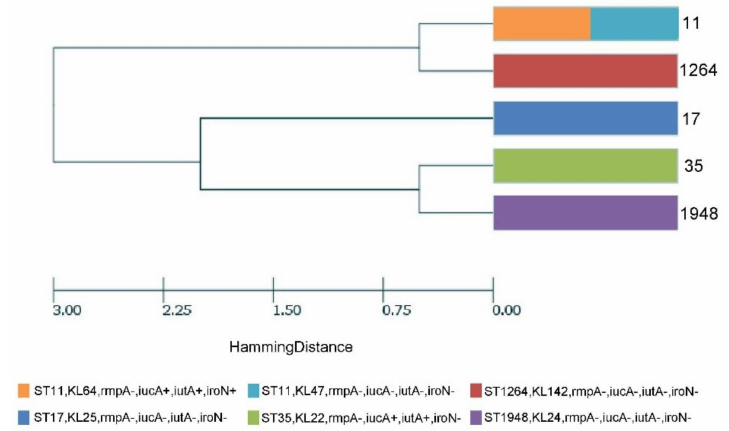
Figure 4. Multilocus sequence typing (MLST), capsular serotyping, virulence factors, and phyloge- netic analysis of the six colonization strains of Klebsiella pneumoniae isolated from the ESLD patients. The numbers listed in right are MLST